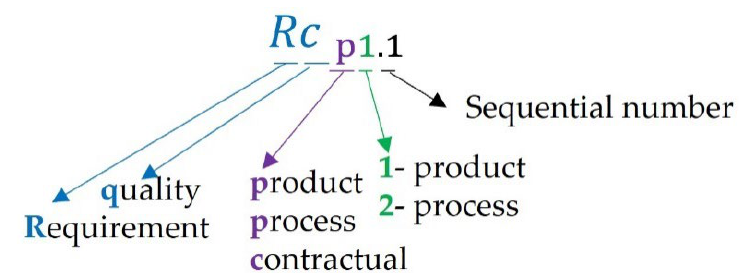
Figure 11. Coding of aerospace structural product quality requirements.